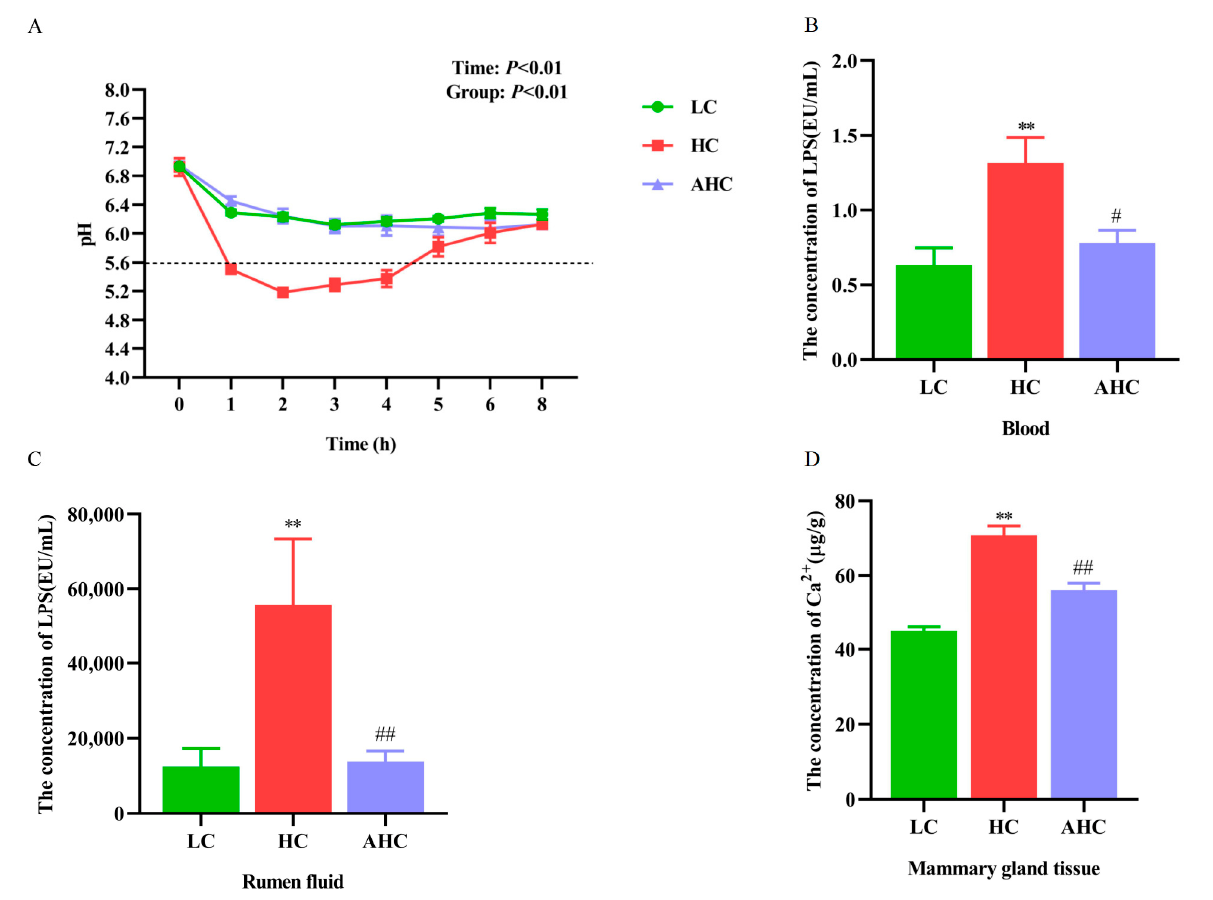
Figure 1. The effects of high-concentrate diet supplemented with disodium fumarate on rumen pH, the LPS content of blood, and rumen fluid, as well as Ca 2+ content in mammary gland tissue. Rumen pH in the three diets ( A ); the content of LPS in blood ( B ) and rumen fluid ( C ); the content of Ca 2+ in the mammary gland tissue of Hu sheep ( D ). The results are presented as the means ± SEM. ** p < 0.01 represents significant differences compared with the LC diet. # p < 0.05, ## p < 0.01, represent significant differences compared with the HC diet.